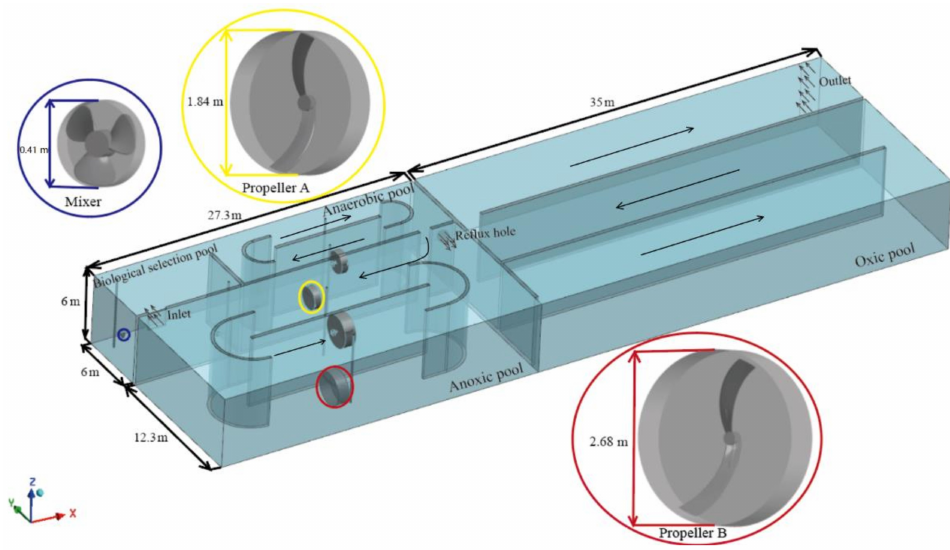
Figure 1. Set up of the A2/0